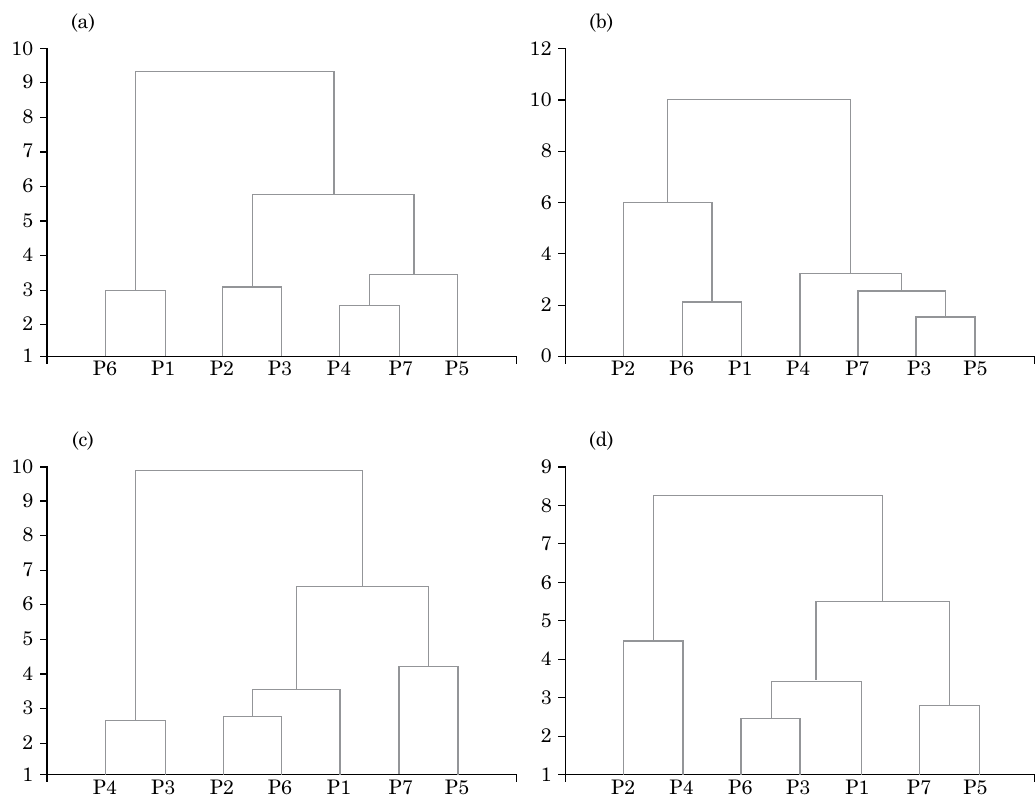
Figura 2. Dendrogramas de agrupamento hierárquico aglomerativo entre os horizontes dos pedons de Cambissolos, pelo método de dissimilaridade por distância euclidiana de acordo com atributos químicos dos horizontes A (a) e B (b) e atributos físicos dos horizontes A (c) e B